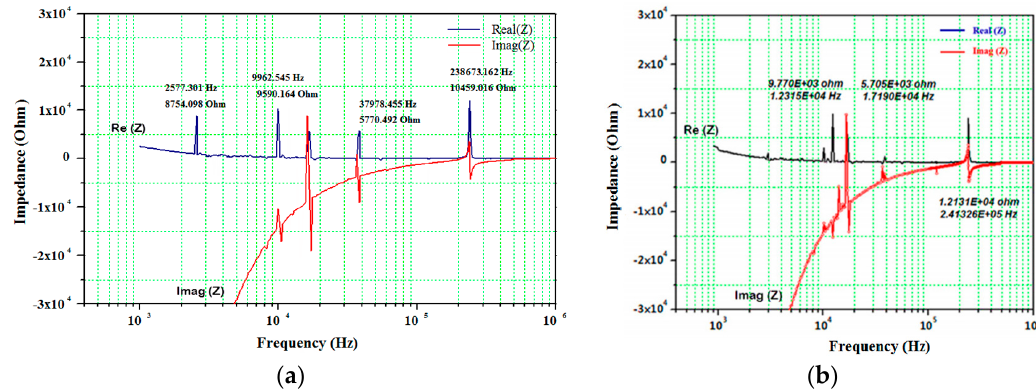
Figure 3. EMI frequency spectrum of sensor A bonded to the aluminum plate at ( a ) 200 °C, and ( b ) 20 °C using the transceiver (flat segments with no peaks have been neglected).